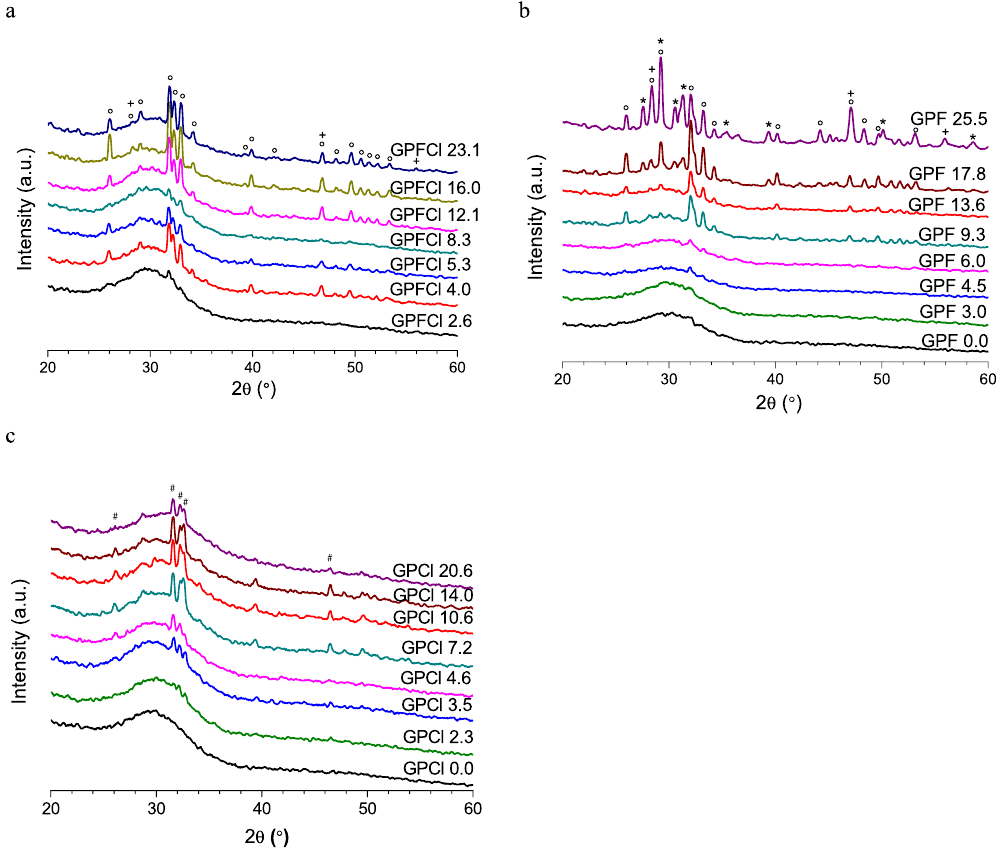
Figure 5. The XRD patterns of as-quenched ( a ) mixed CaF 2 and CaCl 2 containing glasses; ( b ) CaF 2 containing glasses 25 ; ( c ) CaCl 2 containing glasses 23 ( о Ca 10 (PO 4 ) 6 F 2 ; * Ca 4 Si 2 O 7 F 2 ; + CaF 2 ; # Ca 10 (PO 4 ) 6 (OH/Cl) 2